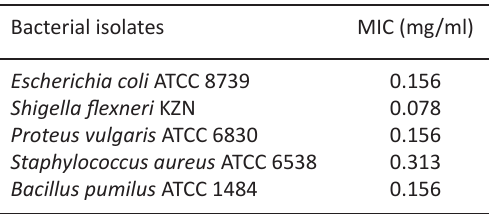
Table 1. Minimum inhibitory concentrations of Acacia mearnsii against bacterial